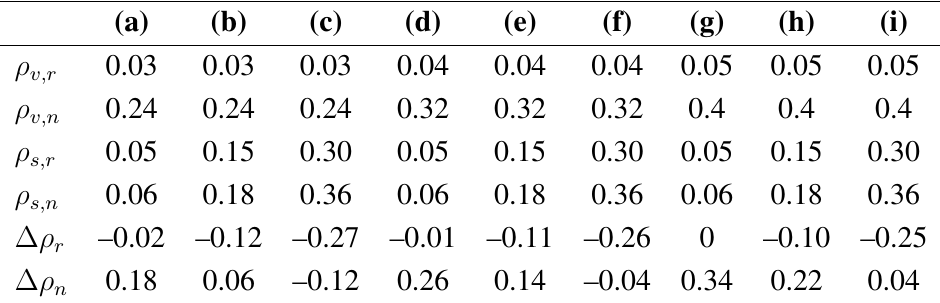
and ρ ) coverage, and the differences between the endmember s;r s;n and ∆ ρ ) used in the numerical r n